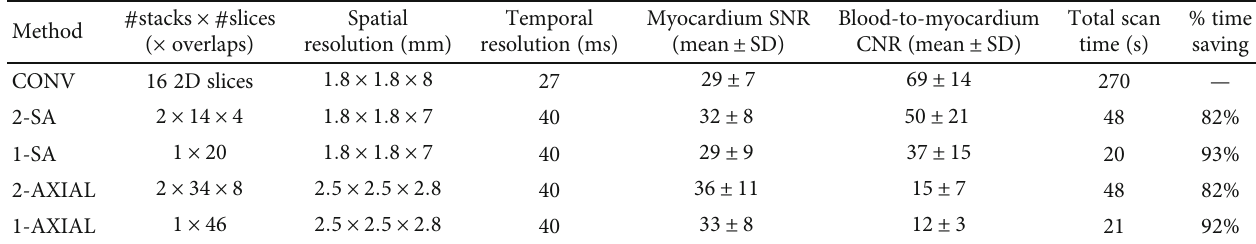
Table 1: Characteristics of di ff erent cine acquisition